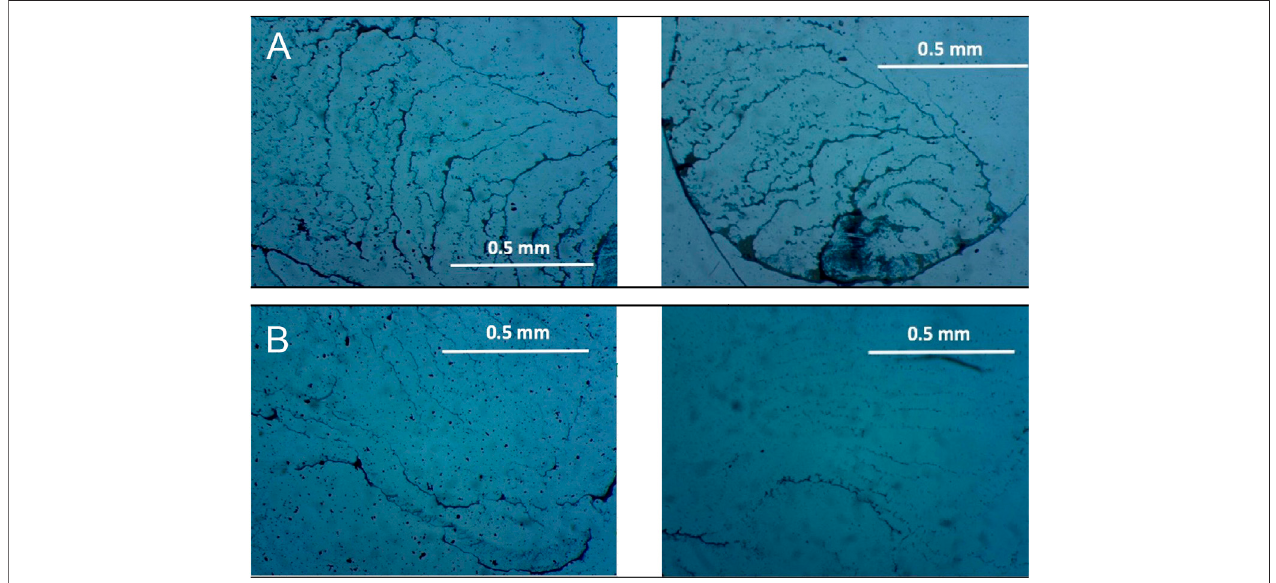
FIGURE 9 | Examples of photos of the distribution of microspheres in dried droplets in 1 × 10 – 9 M HyFn dilution (upper row, (A) ) and of microsphere distribution in driedwater “ dilutions ” drops,correspondingtoadilutionof1 × 10 – 9 M(lowerrow, (B) ).Only2of36dropsobtainedfromthiswater “ dilution ” containstructuressimilarto those shown in (A) .